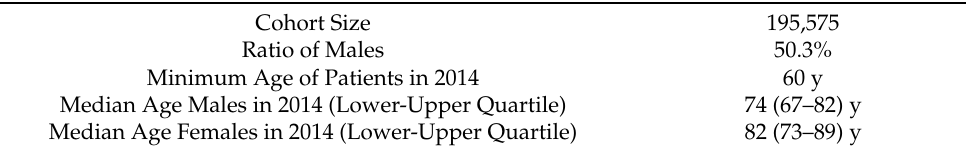
Table 1. Descriptive characteristics of the study cohort.